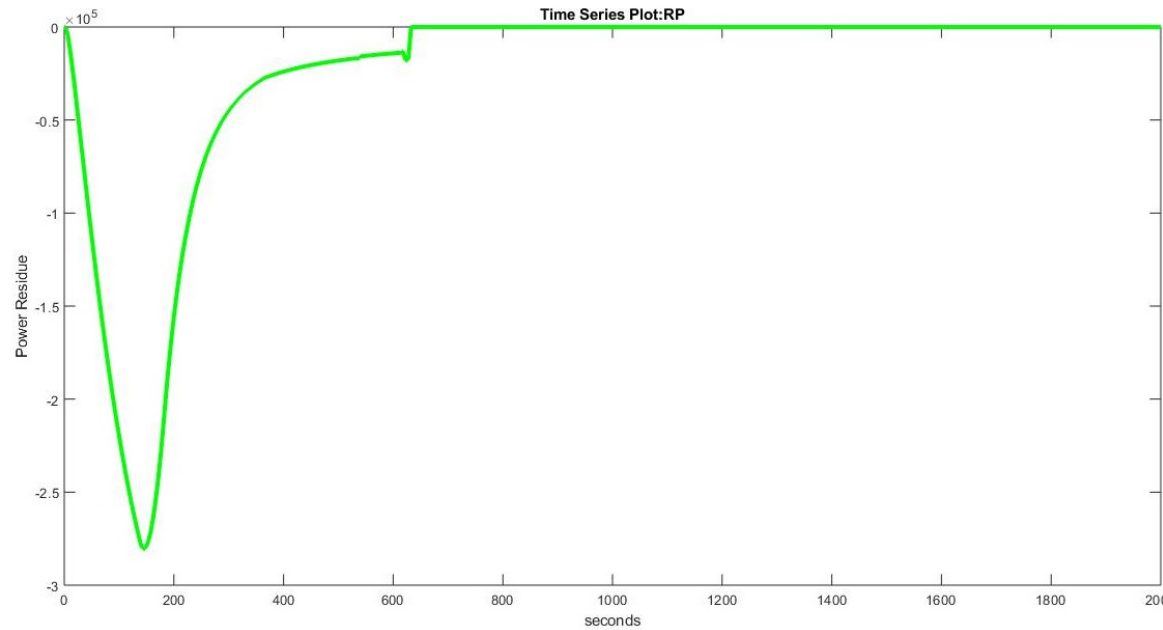
Figure 16. Power residue for the saturation fault of the pond valve s 1 .